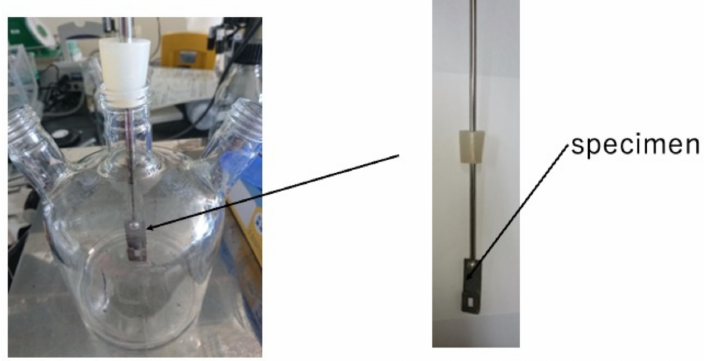
Figure 1. Stirrer-driven rotary biofilm reactor